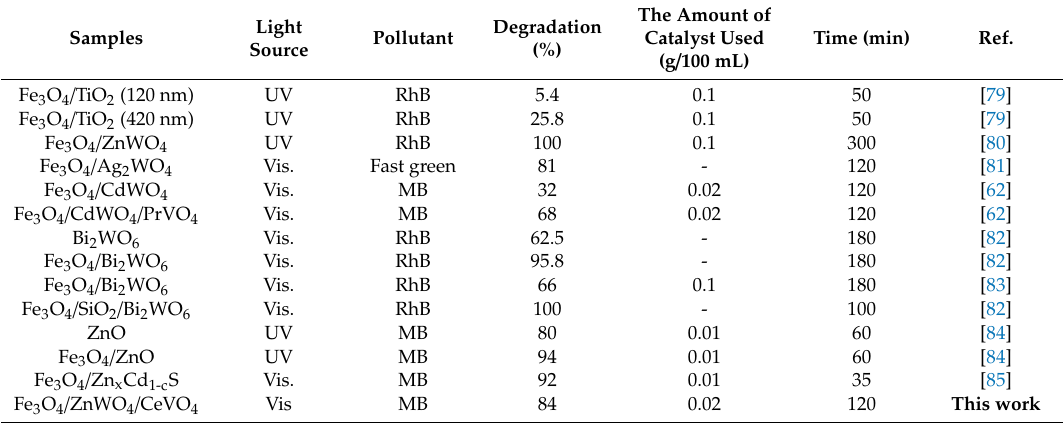
Table 2. Some examples of Fe 3 O 4 -based photocatalysts and their photocatalytic parameters.